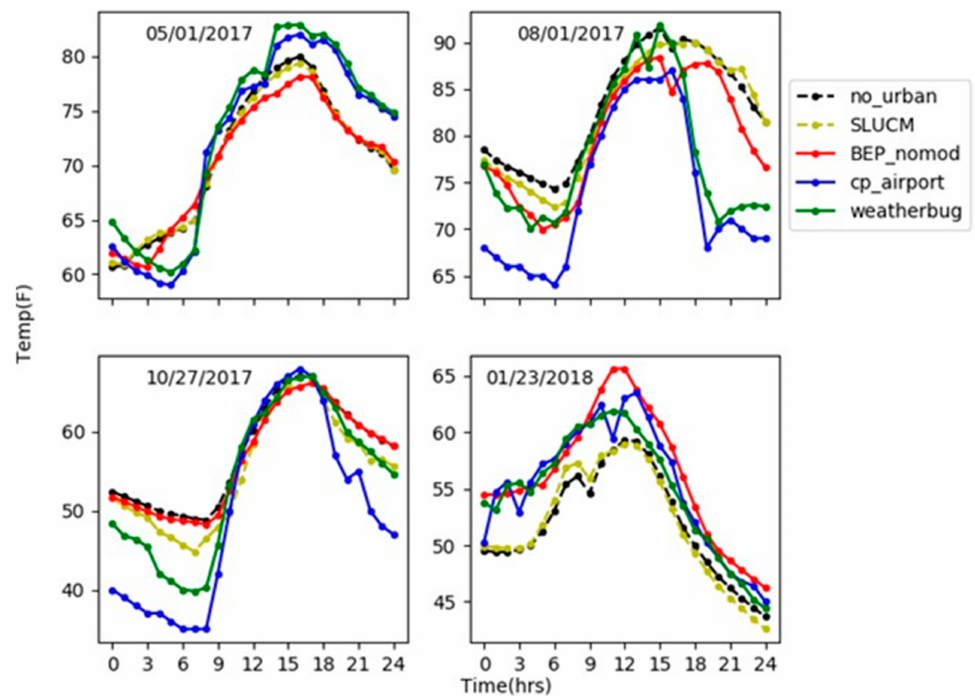
Figure 2. Comparisons of WRF land model-simulated two-meter air temperature with College Park airport and WeatherBug observations. The models are the WRF / Noah default model without urban scheme (“no_urban”), the WRF / SLUCM model (“SLUCM”), and the original WRF / BEP model (“BEP_nomod”). Four di ff erent days were selected to represent di ff erent seasons.